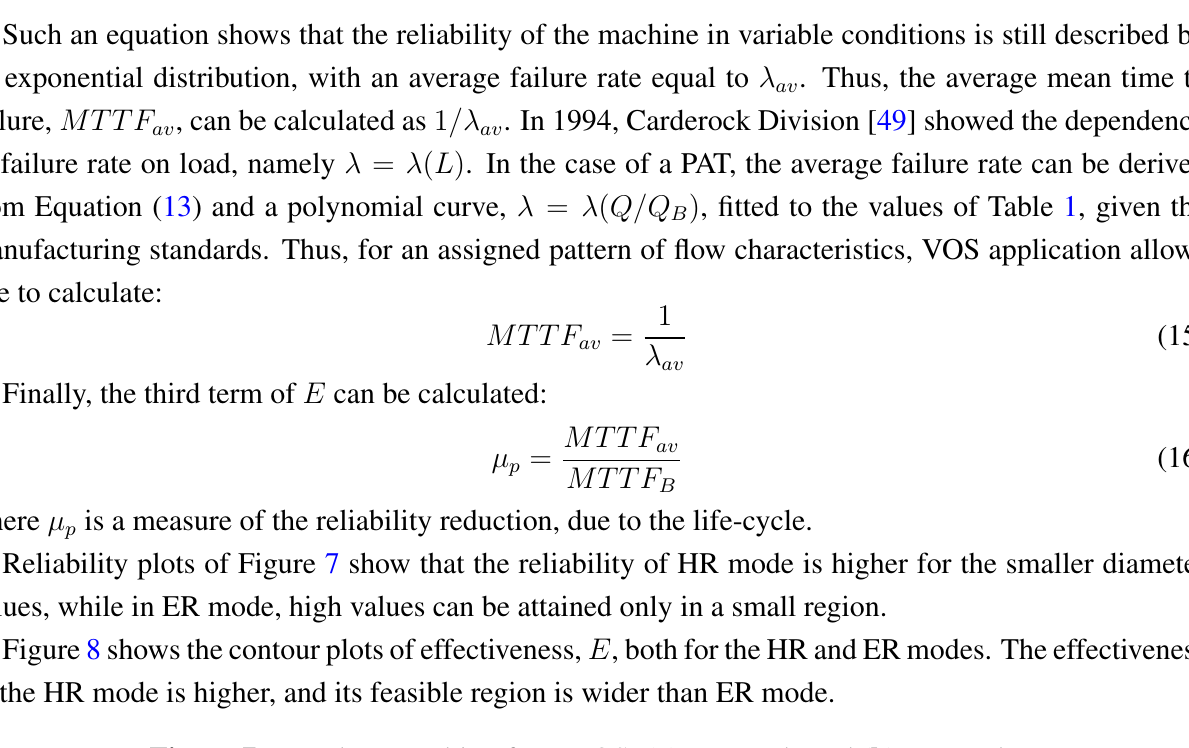
Figure 7. µ values resulting from VOS: ( a ) HR mode and ( b ) ER mode. p